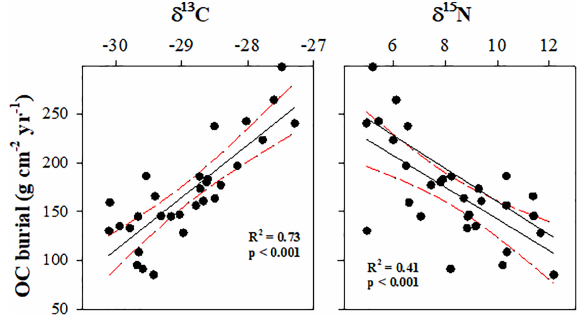
Figure 6. Carbon burial as a function of δ 13 C and δ 15 N.